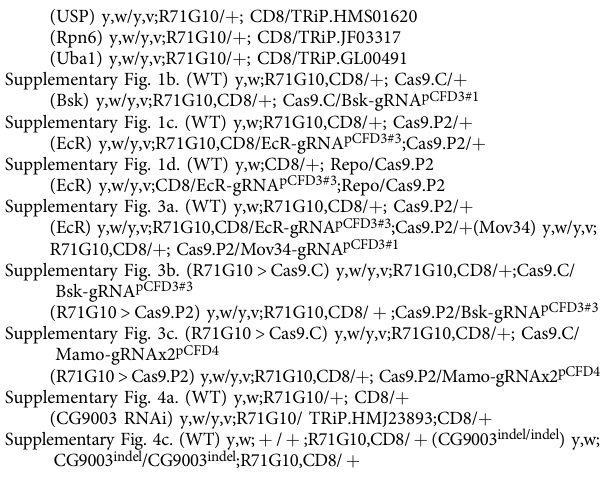
Supplementary Fig. 4a. (WT) y,w;R71G10/ + ; CD8/ + (CG9003 RNAi) y,w/y,v;R71G10/ TRiP.HMJ23893;CD8/ + Supplementary Fig. 4c. (WT) y,w; + / + ;R71G10,CD8/ + (CG9003 indel/indel ) y,w; CG9003 indel /CG9003 indel ;R71G10,CD8/